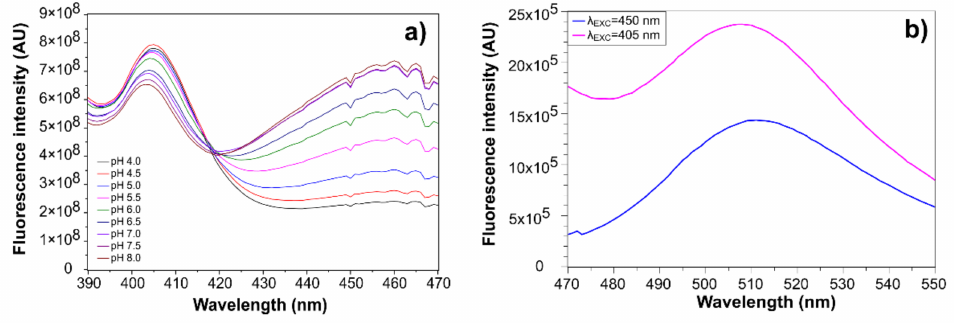
Figure 5. ( a ) Excitation spectra of the sensitive layer on a planar substrate taken at a 508 nm emission wavelength at different pHs; ( b ) and emission spectra taken at 405 nm and 450 nm excitation wavelengths in a buffer solution with pH =